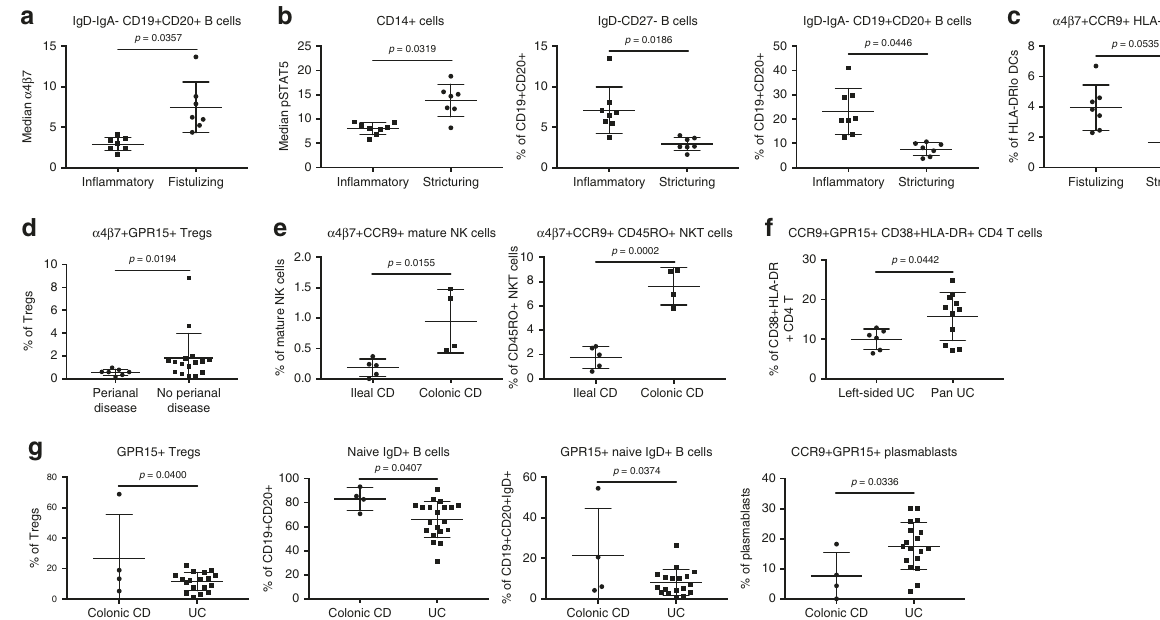
Fig. 3 Circulating leukocytes re fl ect disease heterogeneity. Features signi fi cantly different between in fl ammatory ( N = 7) and fi stulizing ( N = 7) CD ( a ), in fl ammatory ( N = 8) and stricturing ( N = 7) CD ( b ), fi stulizing ( N = 7) and stricturing ( N = 7) CD ( c ), and the presence ( N = 7) and absence ( N = 16) of perianal disease in CD patients ( d ). Statistics: BH FDR-corrected unpaired two-tailed Student ’ s T test using Morpheus (see the Methods section; IgD − IgA − CD19 + CD20 + B cells [median α 4 β 7], t = 3.69; CD14 + cells, t = − 4.36; IgD − CD27 − B cells, t = 3.91; IgD − IgA − CD19 + CD20 + B cells [% of CD19 + CD20 + ], t = 4.38; α 4 β 7 + CCR9 + HLA-DR lo DCs, t = 3.87; α 4 β 7 + GPR15 + Tregs, t = 2.29). Features that distinguish ileal ( N = 5) and colonic ( N = 4) CD ( e ), left-sided ( N = 6) and pan-colonic ( N = 11) UC ( f ), and colonic CD ( N = 4) and UC ( N = 18, or 20 for naïve IgD + B cells) ( g ) identi fi ed by hypothesis- driven testing. Statistics: unpaired two-tailed Student ’ s T test ( α 4 β 7 + CCR9 + mature NK cells, t = 3.18, df = 7; α 4 β 7 + CCR9 + CD45RO + NKT cells, t = 7.15, df = 7; CCR9 + GPR15 + CD38 + HLA-DR + CD4 T cells, t = 2.20, df = 15; GPR15 + Tregs, t = 2.20; df = 20; naive IgD + B cells, t = 2.18, df = 22; GPR15 + naive IgD + B cells, t = 2.23; df = 20; CCR9 + GPR15 + plasmablasts, t = 2.28; df = 20). Center lines = mean; whiskers = standard deviation. Source data